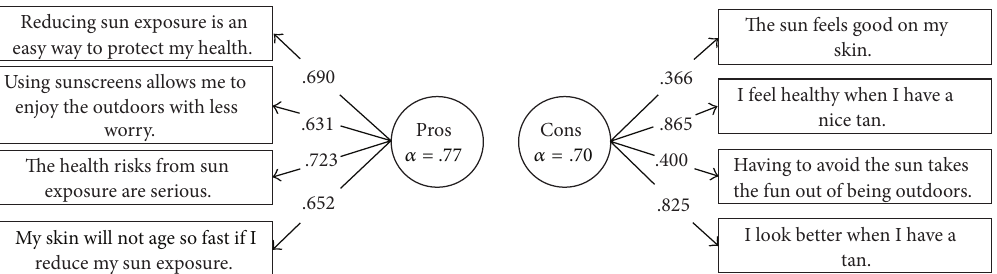
Figure 1: Measurement model for uncorrelated Pros and Cons of sun protection with standardized parameter estimates for full sample ( 𝑁 = 1336